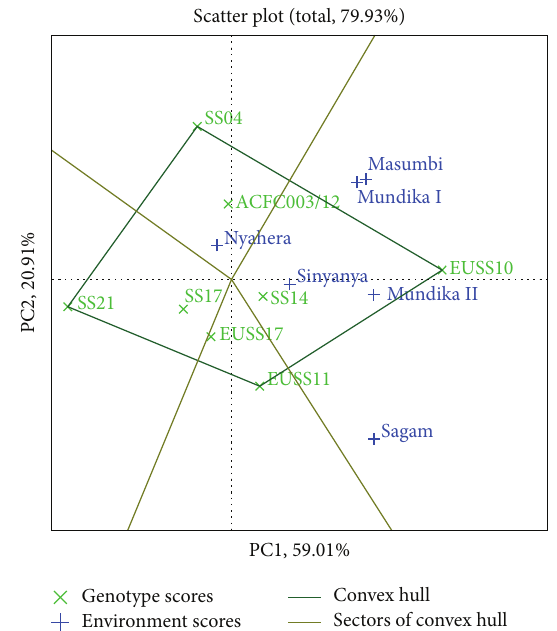
Figure 4: The which-won-where view of GGE biplot for juice